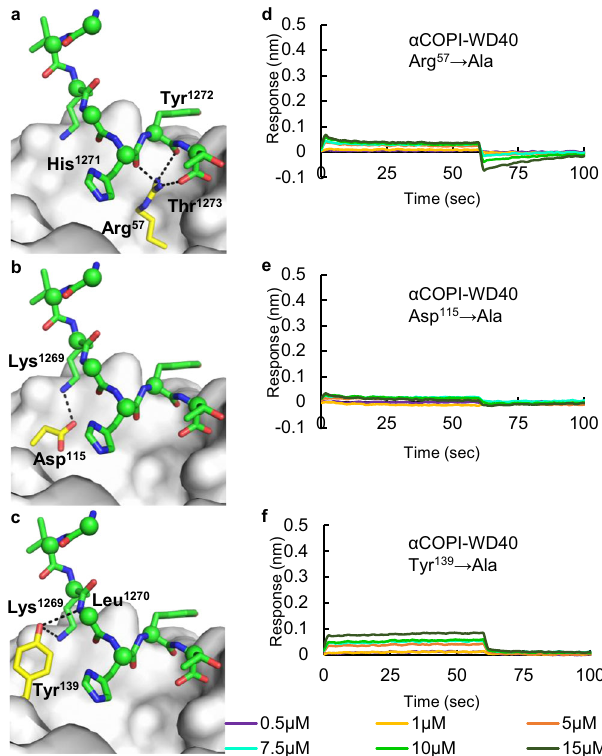
Fig. 6 Structure-guided mutagenesis of α COPI-WD40 domain and binding analysis with spike hepta-peptide. Panels ( a – c ) highlight the hepta-peptide interactions (within 4 Å) of ( a ) Arg 57 , ( b ) Asp 115 , and ( c ) Tyr 139 residues in α COPI-WD40 in an in silico model. These three interacting α COPI-WD40 residues are shown as yellow-red-blue sticks whereas the other residues are shown as a yellow surface for simplicity. The corresponding interacting residues in the spike hepta-peptide are labelled and shown as green-red-blue sticks and spheres for C α atoms. The BLI analysis of Arg 57 → Ala, Asp 115 → Ala, and Tyr 139 → Ala mutants with the wild-type spike hepta-peptide is shown in panels ( d ), ( e ), and ( f ), respectively. All three mutants demonstrate no substantial binding of the spike hepta-peptide. One representative experiment of three is shown in panels ( d – f